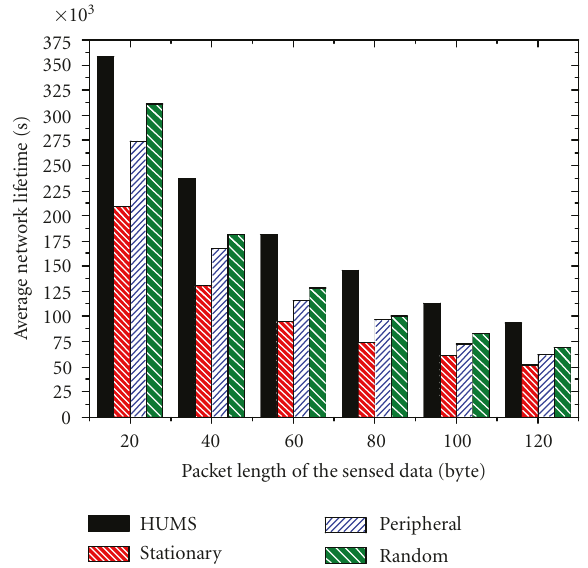
Figure 14: Network lifetimes varied with di ff erent packet sizes of the sensed data. (The initial energy for each node is